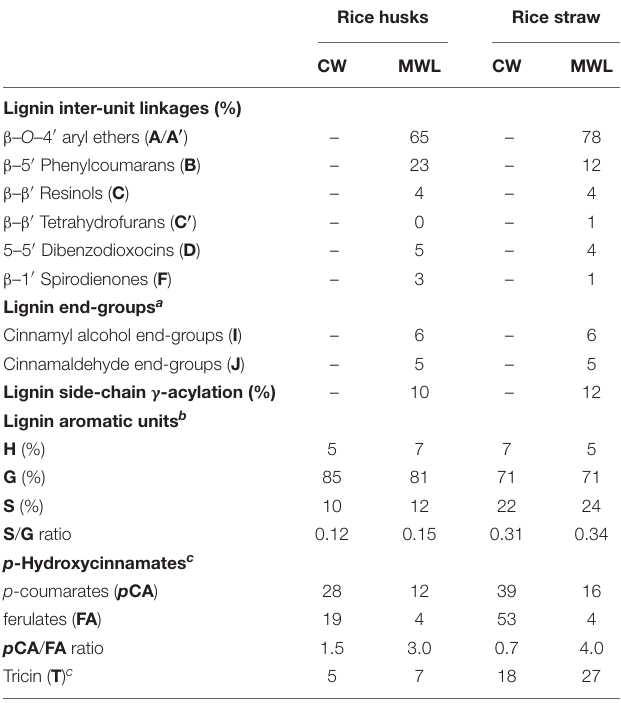
TABLE 4 | Structural characteristics (lignin inter-unit linkage types, end-groups, γ -acylation, aromatic units, and S/G ratio, cinnamate content, and tricin content) from integration of 1 H/ 13 C correlation signals in the HSQC spectra of the whole cell walls (CW) of rice husks and rice straw and their isolated